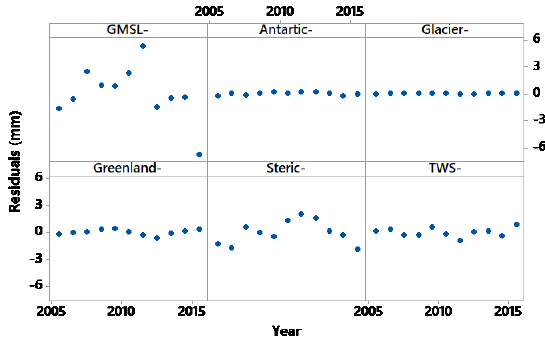
Fig. 2. Residuals of the regression solutions for the linear trends of the budget